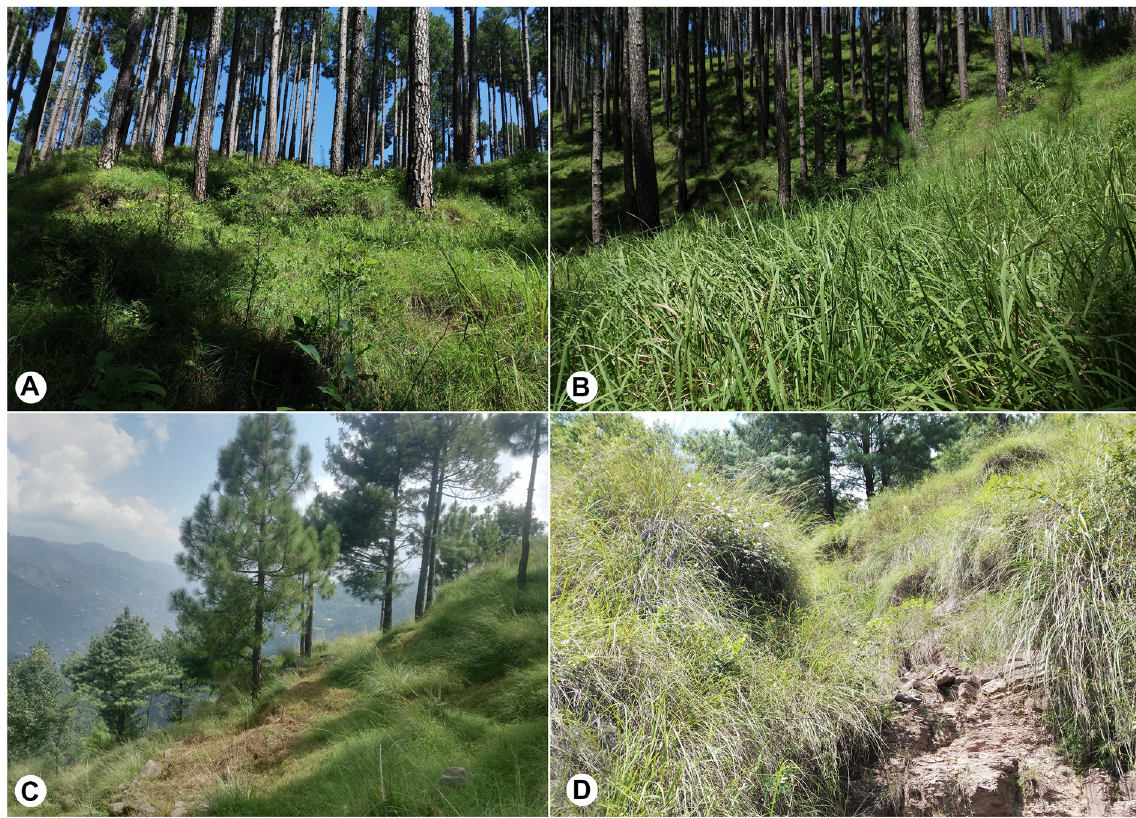
Fig. 5. Habitat of Baliga kashmirensis sp. nov. A – B . Khyber Pakhtunkhwa: Bajna. C – D . Azad Kashmir: Khai